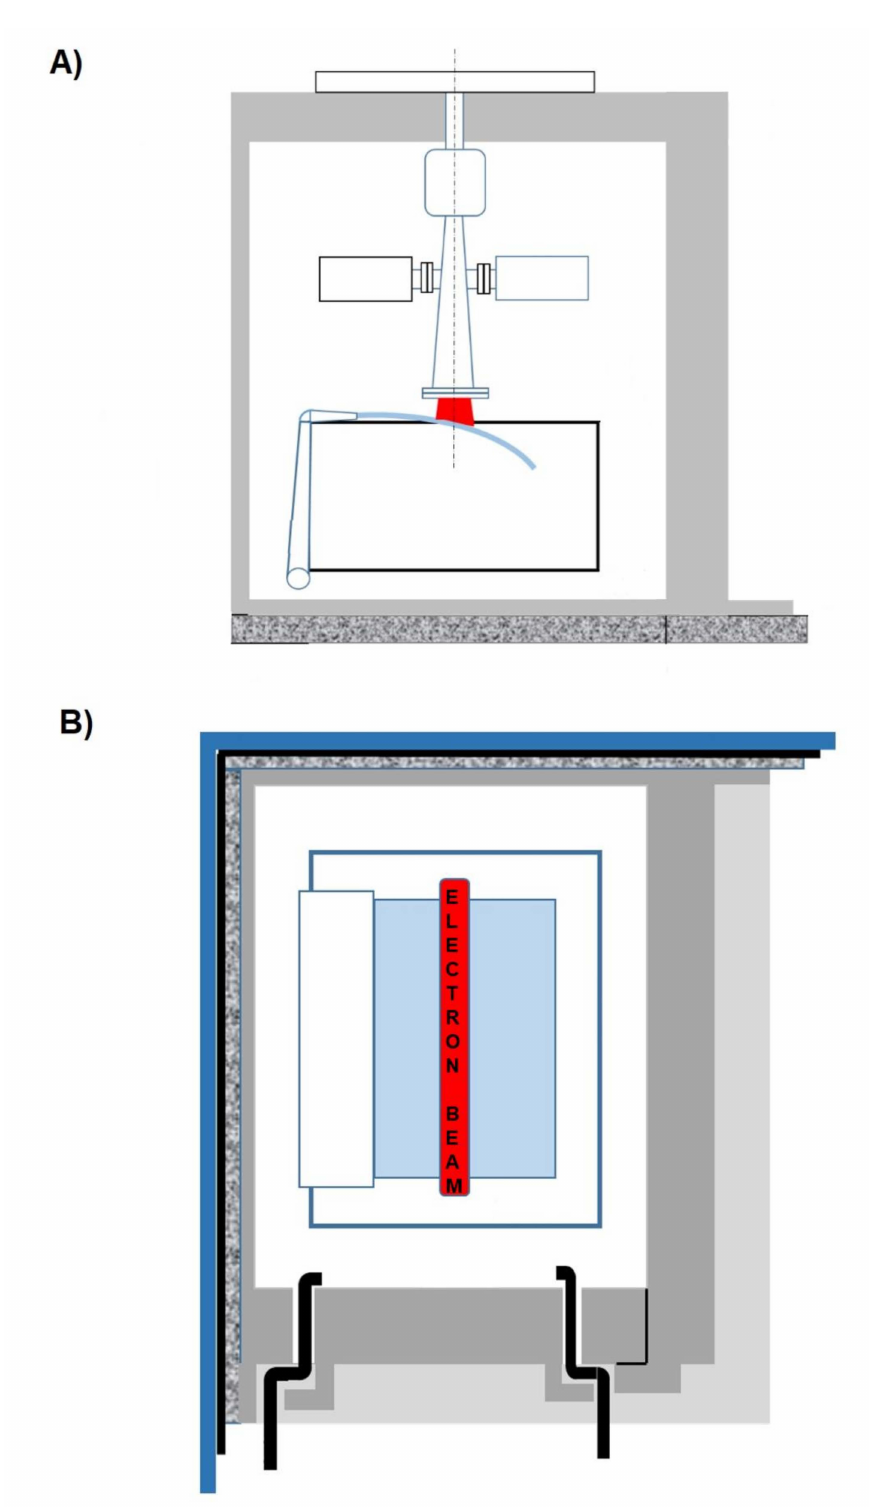
Figure 2. Diagram of the projected under beam water stream formation and irradiation chamber: ( A ) side view, ( B ) plan